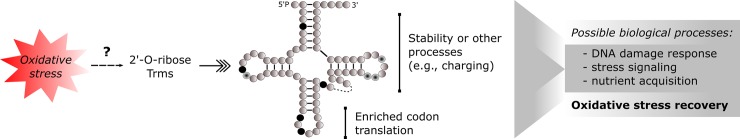
A hypothetical model for how 2'-O-ribose tRNA methylation promotes oxidative stress recovery.In this model, 2'-O-ribose Trms are responsive to oxidative stress exposure by unknown signaling events or pathways as indicated by the question mark. Trms then target various tRNAs for 2'-O-ribose methylation at positions that have previously been implicated in increased tRNA stability, amino acid charging, and enhanced translation of transcripts enriched in certain codons. Possible biological processes that may be involved in oxidative stress recovery via this type of translational regulation were identified at a bioinformatic level. The precise role of Trm-dependent 2'-O-ribose methylation for enhanced decoding of transcripts associated with these biological processes has yet to be determined.